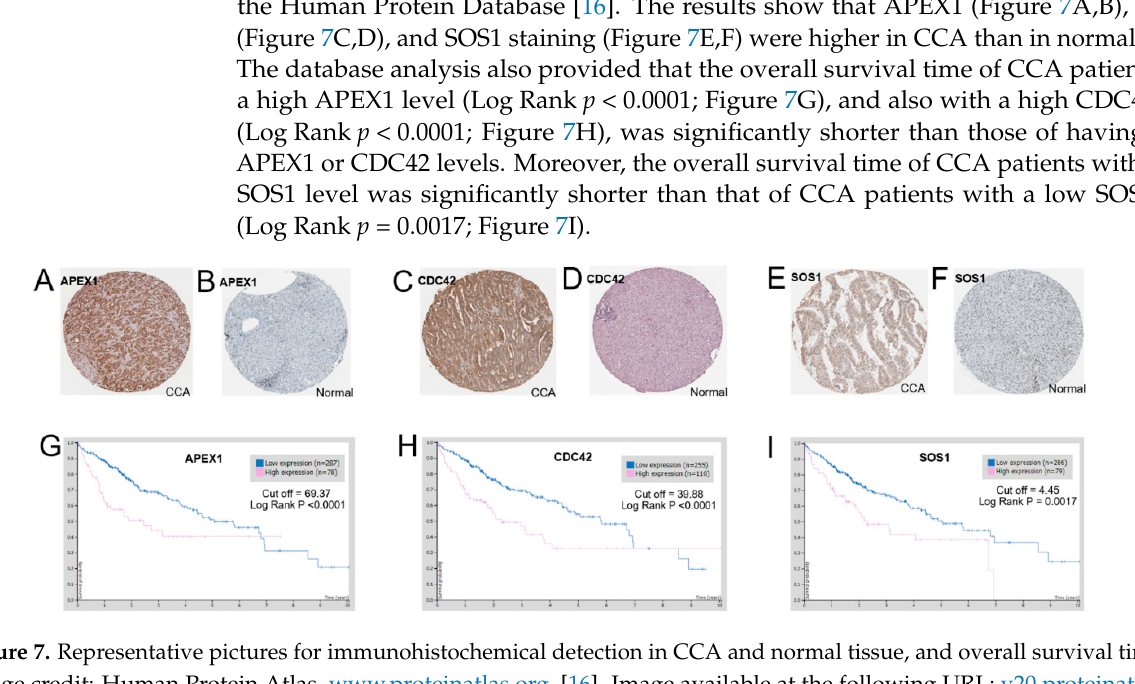
6 of 12 Figure 6. Box diagram of the expression of the RNA level between CCA and normal tissues. Image credit: GEPIA, http://gepia.cancer-pku.cn/ (Accessed on 2 March 2021) [15]. CCA tissue samples are represented by the left box. Normal tissue samples are represented by the right box. RNA ex- pression levels of ( A ) APEX1, ( B ) CDC42, and ( C ) SOS1. 2.7. Protein Expression Levels of APEX1 and Related Proteins in CCA Tissues